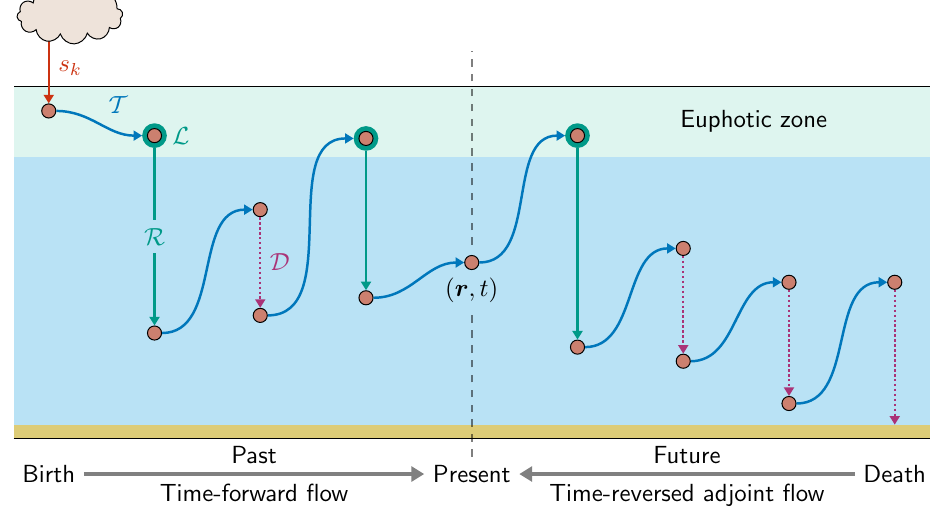
Figure 1. Schematic of the birth-to-death life cycle of a labeled DFe molecule (red dot). As captured by Eq. (2), the molecule makes several passages through the biological pump (green, uptake L and regeneration R ) and through the scavenging pump (purple dotted, D ) while being transported by the ocean circulation (blue, T ) from its birth (red, s k , here the aeolian source) to its death by eventual burial in sediments following scavenging. This particular DFe molecule passed n = 2 times through the biological pump since its birth and will pass m = 1 times through the biological pump until its death. We consider the DFe concentration at location r and at present time t . Our diagnostics partition DFe at ( r ,t) into the fractions that have undergone n regenerations since birth and that will undergo m regenerations until death. Computationally, we track DFe from its birth to the present using the usual time-forward flow, while we track DFe backward in time from its death to the present using the time-reversed adjoint